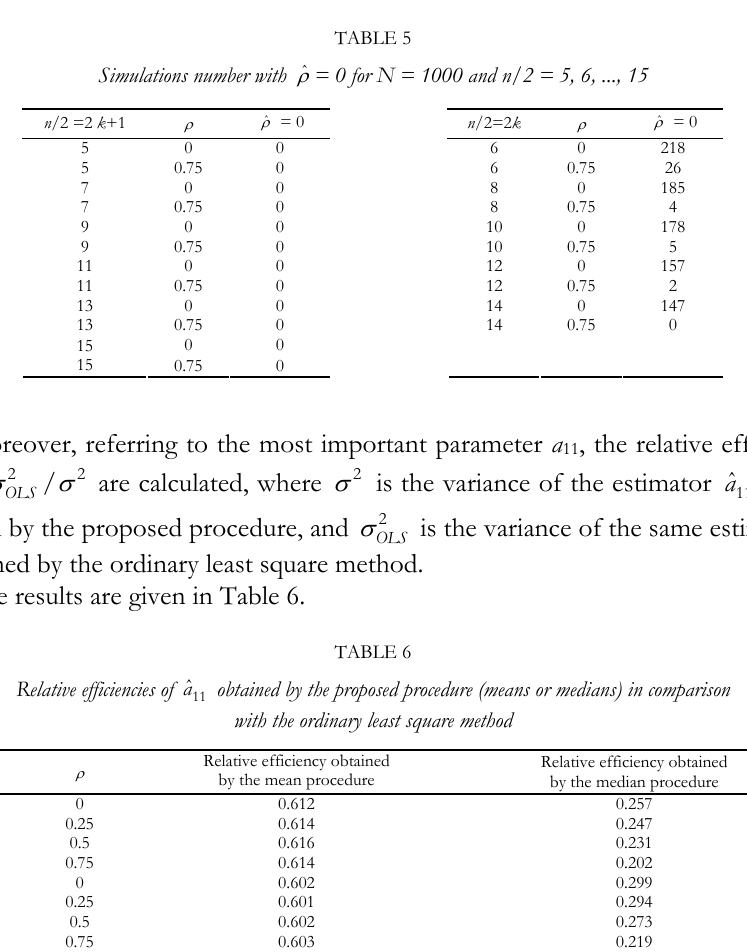
Relative efficiency obtained by the median